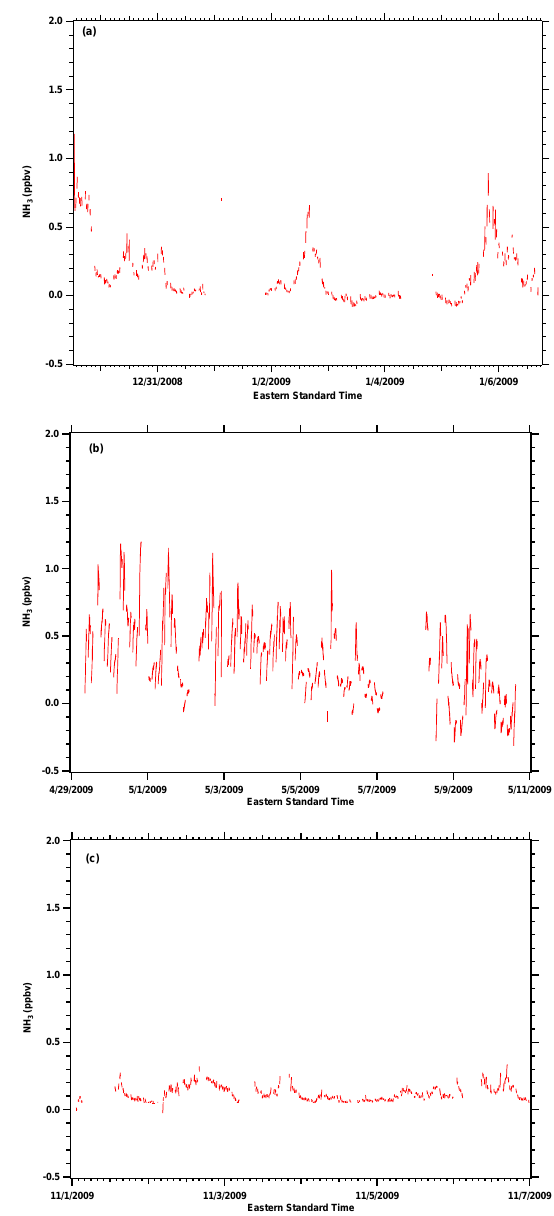
Fig. 6. The ambient [NH 3 ] measured in Kent, Ohio, during the winter over an 8 day span (a) , during the spring for 12 days (b) , and during the fall for 6 days (c)